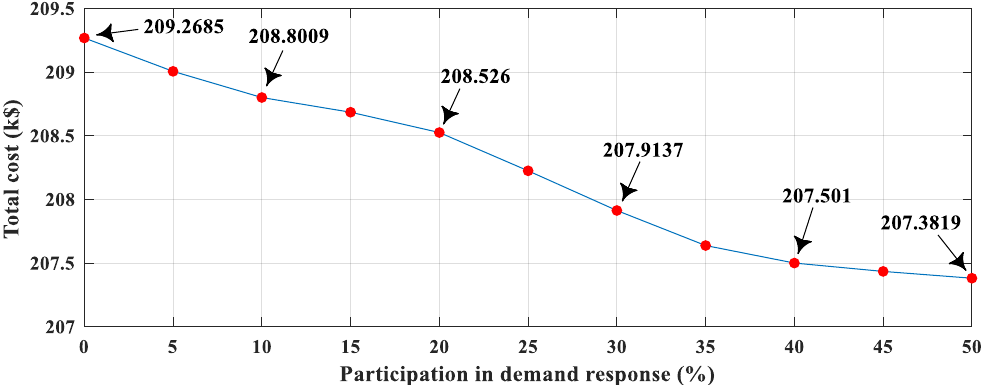
Figure 10. Hourly shifted load percent in a typical day in week 15 for different participation percent in demand response (positive: added loads, negative: reduced loads).